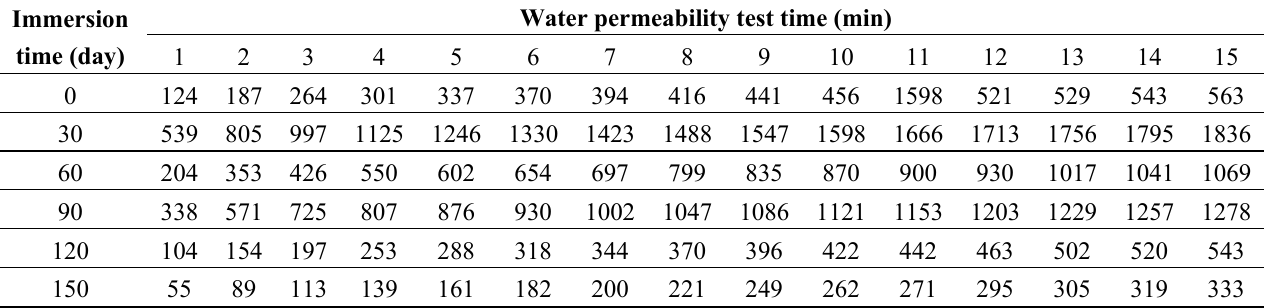
Table 2. Seepage volume of concrete CF15 sample under ultrapure water-eroding procedure within 15